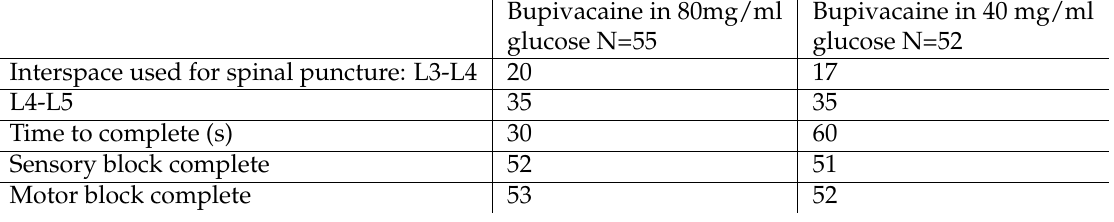
Characteristics of the spinal puncture and the success rate of spinal anesthesia in the two groups(number %)